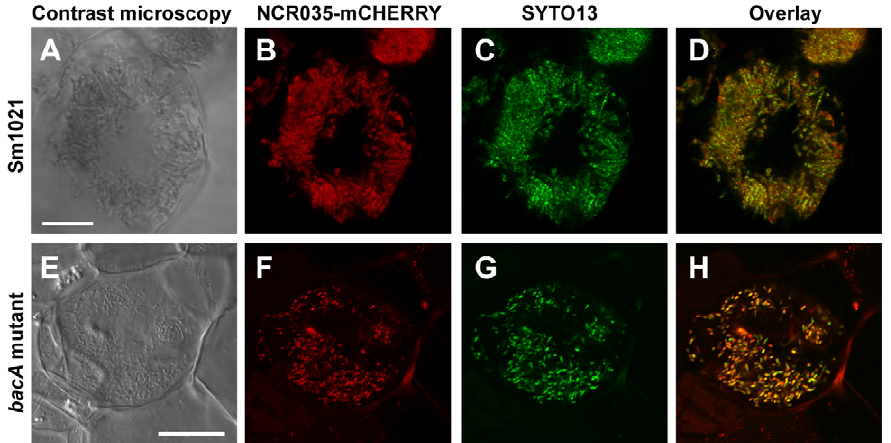
Figure 2. The S.melilotibacA mutant is challenged with NCR peptides. Microscopy of transgenic M. truncatula nodule cells expressing NCR035-mCHERRY under the control of the NCR035 promoter infected with either the S. meliloti wild-type (A–D) or BacA-deficient mutant (E–H) strains. Differential Interference Contrast microscopy (A,E), confocal microscopy of NCR035-mCHERRY localization (red) (B and F), bacterial localization with the DNA stain SYTO13 (green) (C,G), and an overlay of NCR035-mCHERRY and SYTO13 localization (D,H). In both the wild-type and BacA- deficient mutant infected nodules, NCR035 co-localizes with the bacteria. Scale bars are 10 m m.